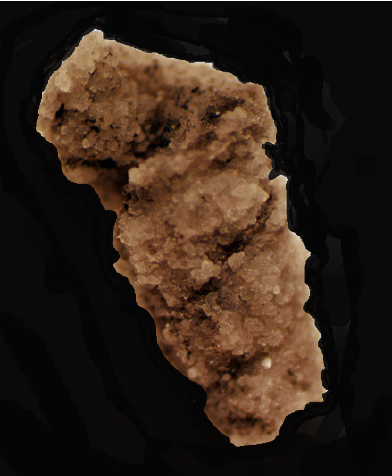
Figure 9. Abyssochrysoid gastropod (IGM 5010b). Varix-like axial ribs are still visible on this side of the specimen in spite of relatively coarse silicification.